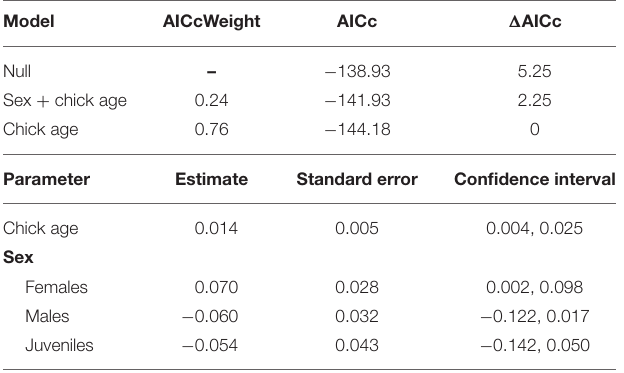
TABLE 2 | Top model set of factors influencing variation in the proportion of time helpers invested in young per brood observation (for full set of models tested see Supplementary Material S3 ).